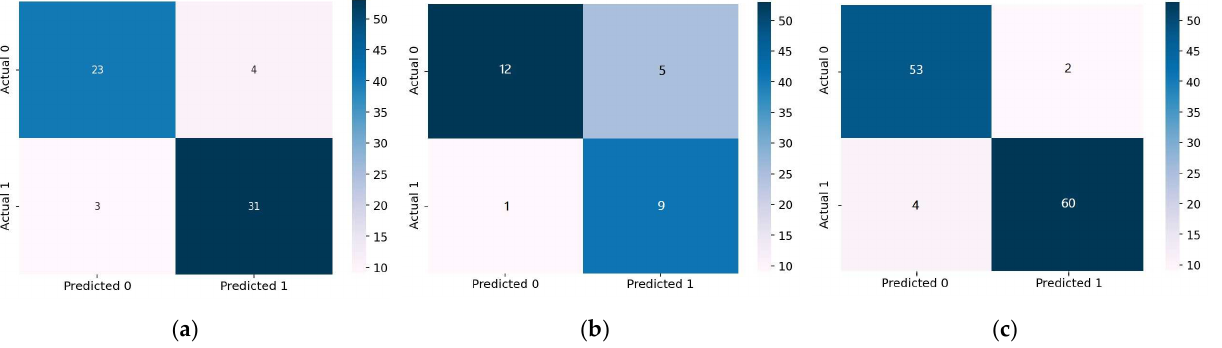
Figure 12. Confusion matrix of the Bi-LSTM model. ( a ) Cleveland dataset; ( b ) Statlog dataset; ( c ) Comprehensive dataset.